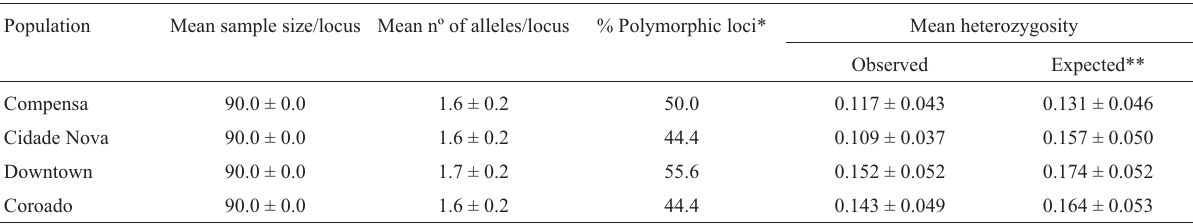
Table 2 - Estimate of measures of genetic variability in A. aegypti populations. Population Mean sample size/locus Mean nº of